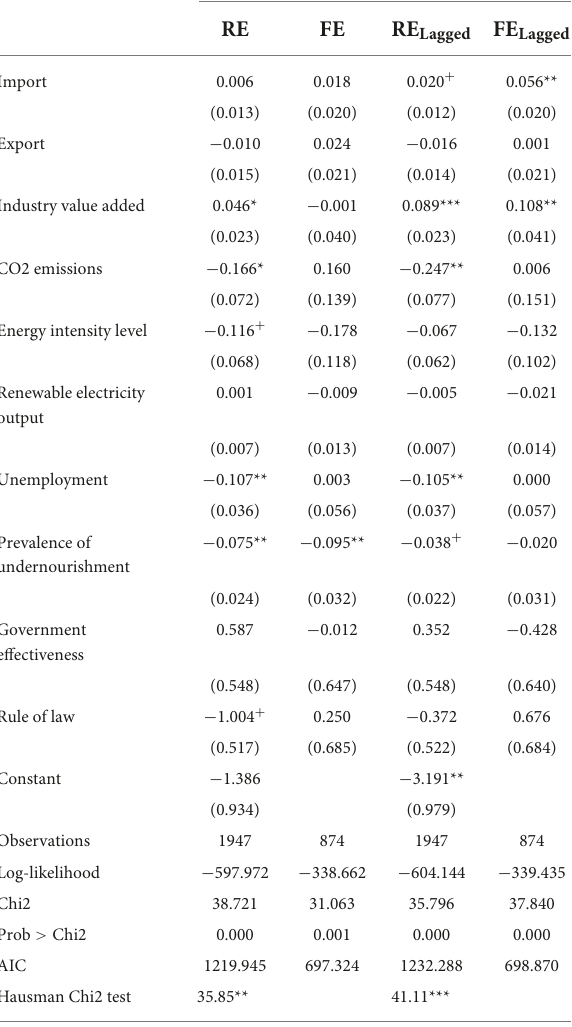
TABLE 5 Panel logistic regression results.